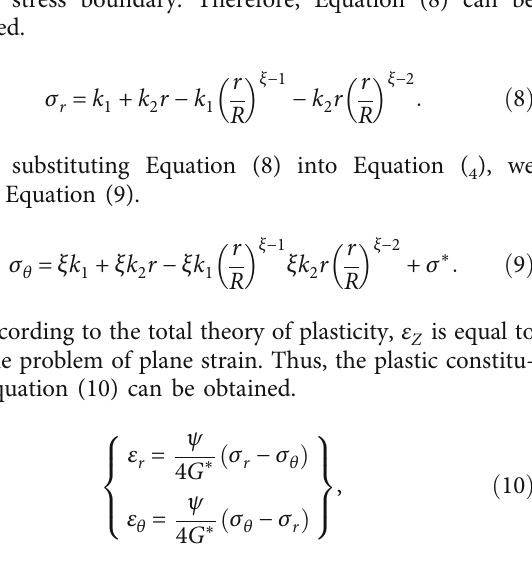
Figure 5: Tangential stress distribution of di ff erent pore